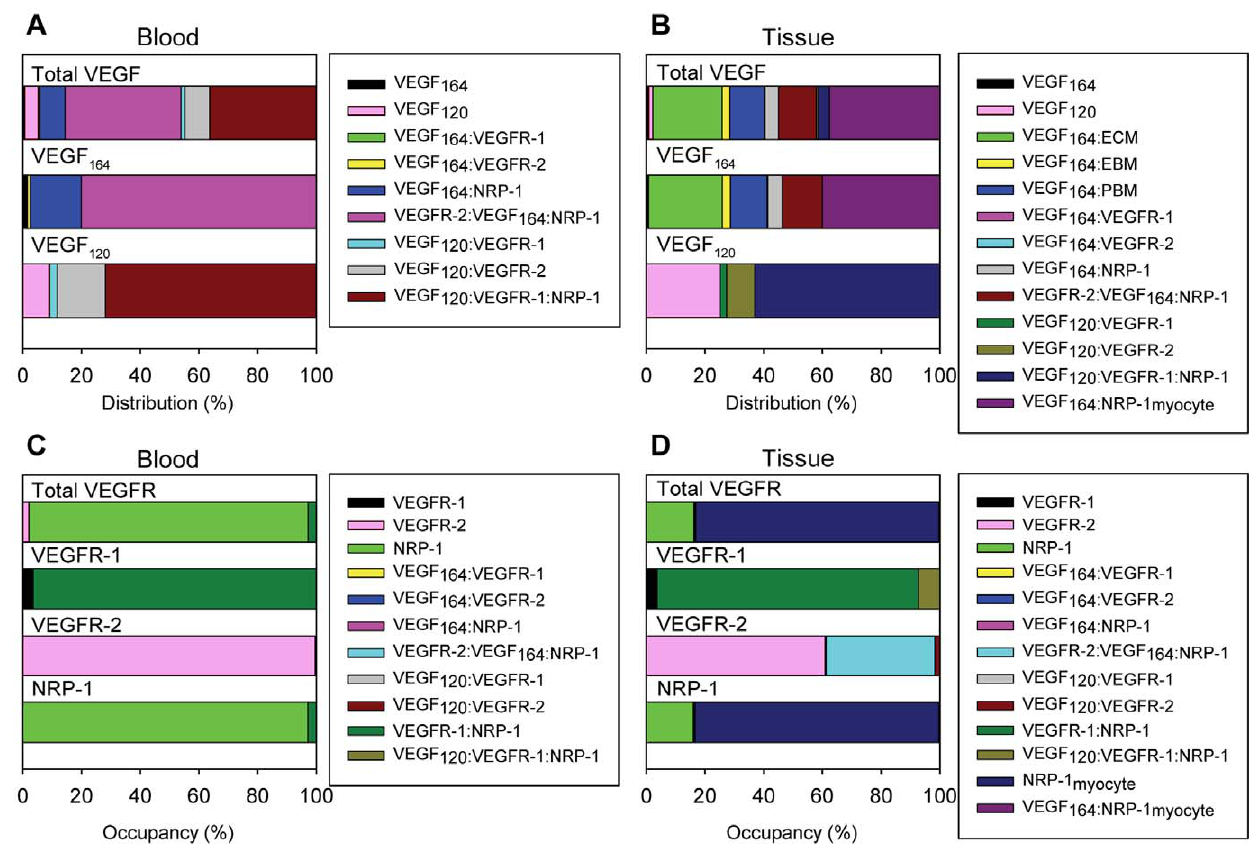
Figure 7. VEGF distributions and VEGFR occupancies at steady-state. The distributions of total VEGF and of the two individual isoforms are shown for the (A) blood and (B) tissue compartments. In the blood compartment, the majority of VEGF is found in the form of the VEGFR-2/VEGF 164 / NRP-1 and VEGF 120 /VEGFR-1/NRP-1 ternary complexes. In the tissue compartment, most of the VEGF is in the form of the VEGF 164 isoform bound to NRP-1 on the myocytes. The occupancies of total VEGF receptors and of the individual receptors are shown for the (C) blood and (D) tissue compartments. Unbound NRP-1 on the luminal endothelial cell surface makes up the majority of total receptors and complexes in the blood compartment. Similarly, unbound NRP-1 on the abluminal endothelial cell and myocyte cell surfaces makes up the majority of total receptors and complexes in the tissue compartment.